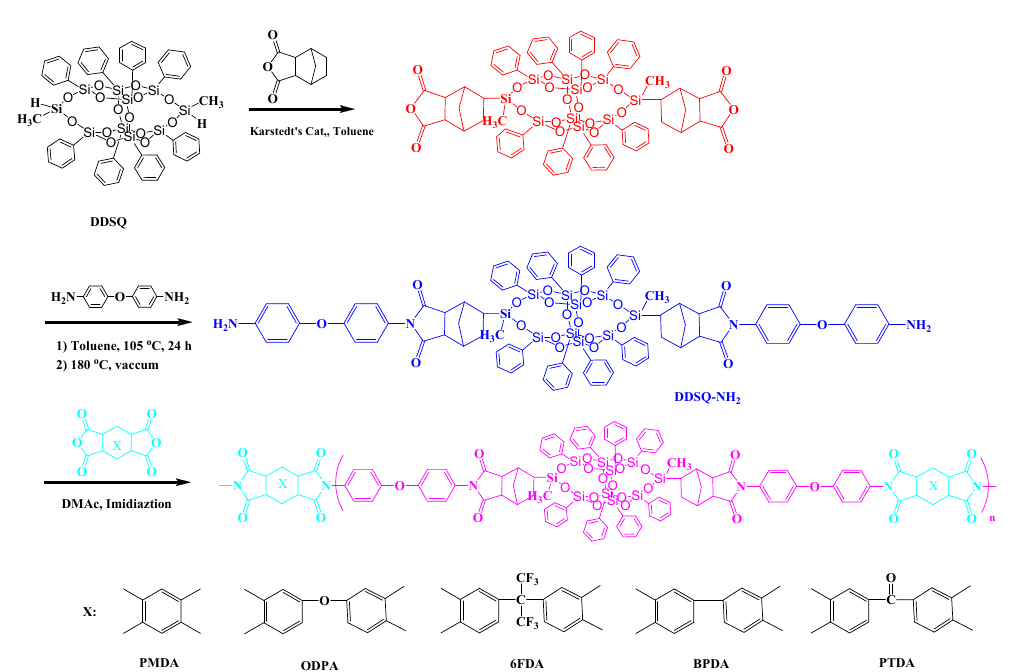
Figure 9. Preparation of semi-aromatic PIs containing a double-decker-shaped silsesquioxane (DDSQ) in the main chain [80]. Reproduced with permission from the American Chemical Society.